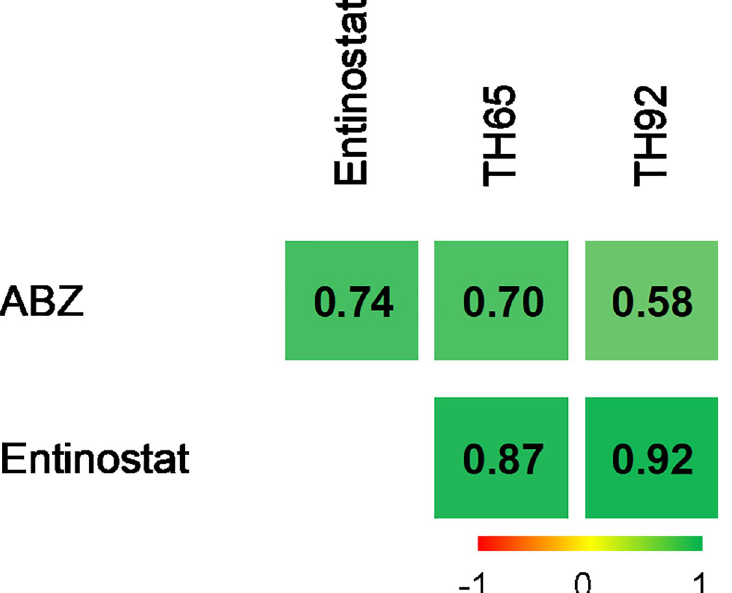
Fig 7. Classification of the anthelmintic effect determined for pairwise drug combinations of selected HDAC inhibitors and albendazole (ABZ). The proportional effect indices were determined for all binary drug combinations of HDAC inhibitors and ABZ tested. The values are displayed in a heat-map format to display the deviation away the different combinations’ merely additive predicted effects. Index values range from -1 to +1. The predicted additive effect index (0) is depicted in yellow. If the effect determined for the pair of compounds is higher than the predicted outcome, it is indicated in green; if the determined effect is lower, it is indicated in red. The proportional effect indices were calculated from three independent biological replicates, each in